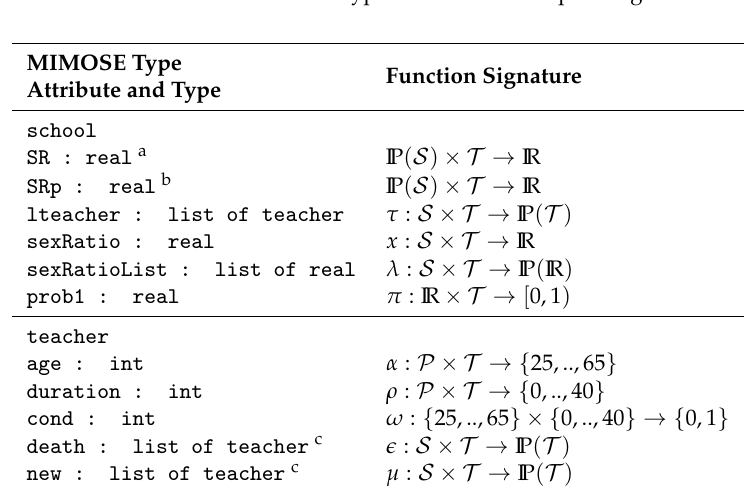
Table 3. Variable attributes of the MIMOSE types and their corresponding function